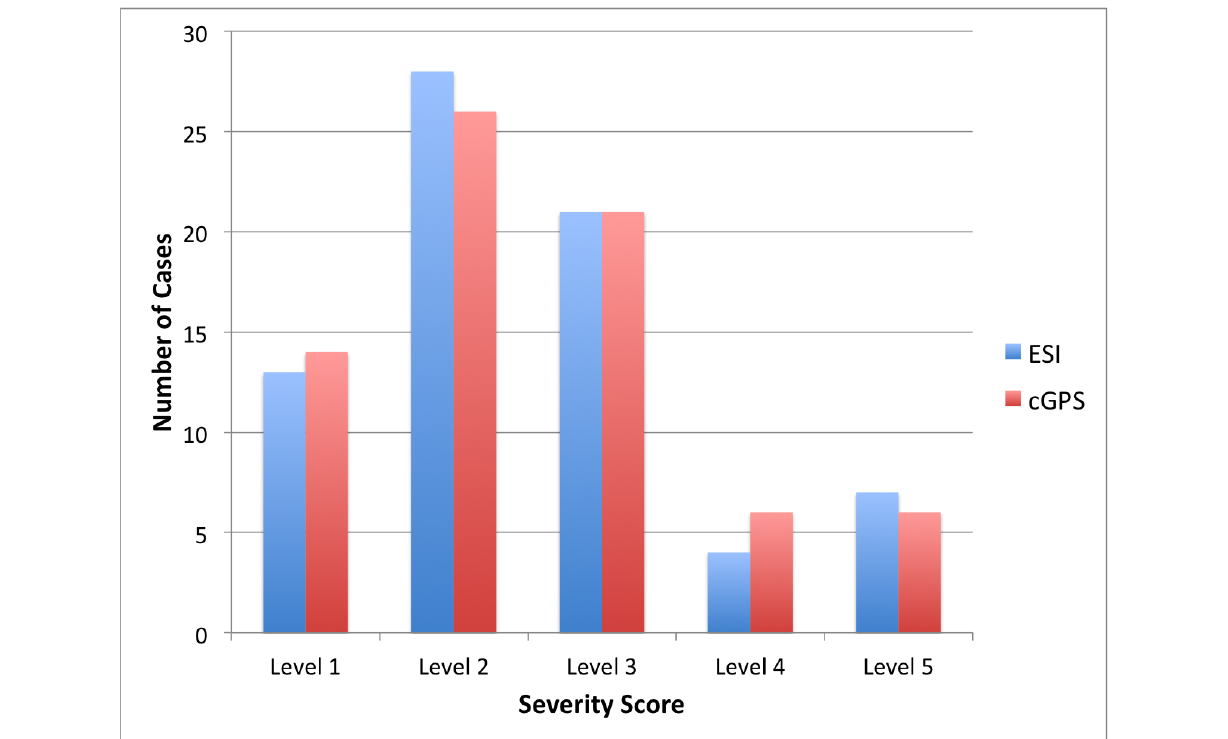
Figure 5. Distribution of Emergency Severity Index (ESI) and clinical GPS v2.0 (cGPS) severity scores for the case vignettes (n=73).